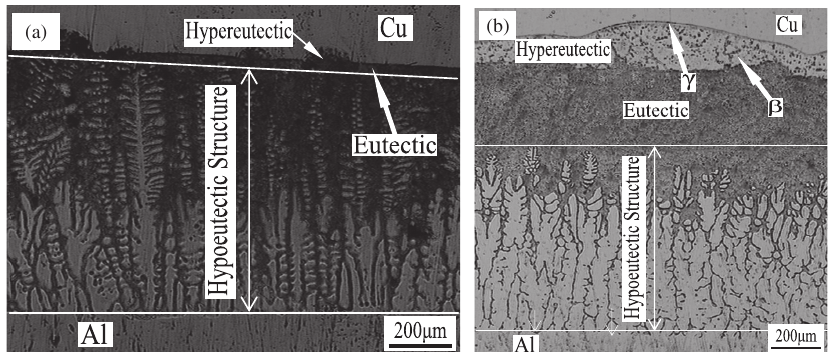
Figure 4: Metallograph of the solidifica- tion microstructure in the transition layer: (a) holding for 60 s; (b) holding for 110 s.